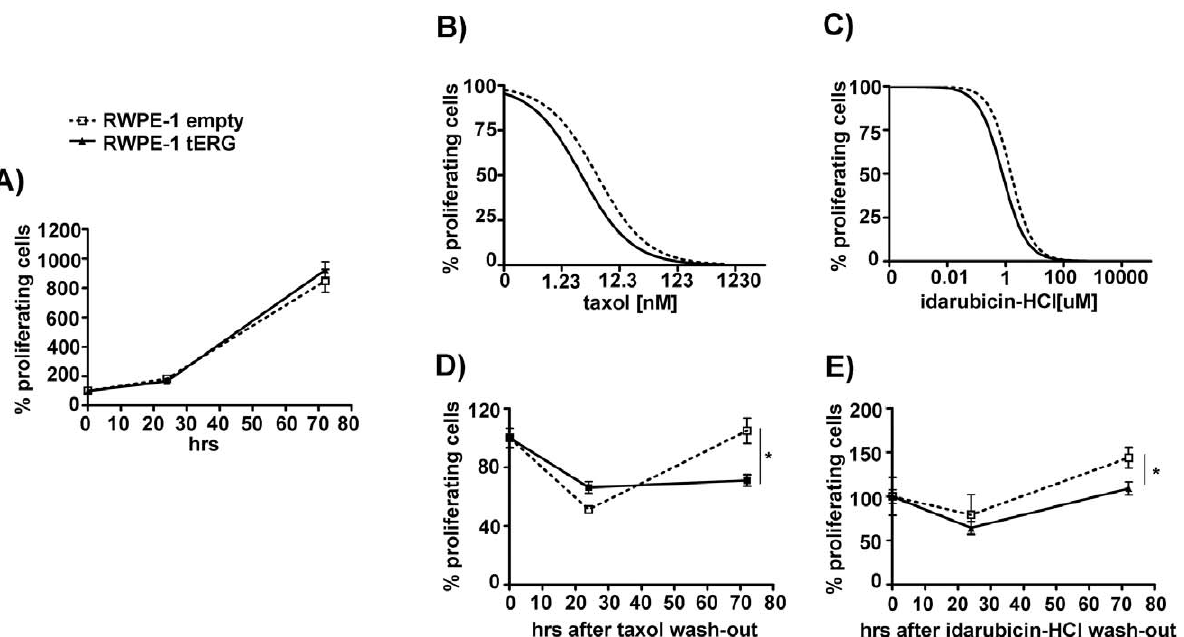
Figure 4. Sensitivity of RWPE-1_tERG cells to chemotherapeutic drugs. a ) Proliferative potential of tERG over-expressing and control (empty) cells measured by thymidine uptake assay up to 72 hrs growth in standard conditions. b–c ) 72 hours treatment of RWPE-1 transfectants with taxol or idarubicin-hydrochloride. Proliferative potential was measured by thymidine uptake assay. d–e ) Re-growth of RWPE-1 transfectants after 10 nM taxol ( d ) or 0.5 m M idarubcicin-hydrochloride ( e ): following 24-hrs treatment, drugs were removed and the cells allowed to grow for additional 72 hours. Proliferation of cells collected at the time of wash-out is set as 100%. *=p , 0.05.